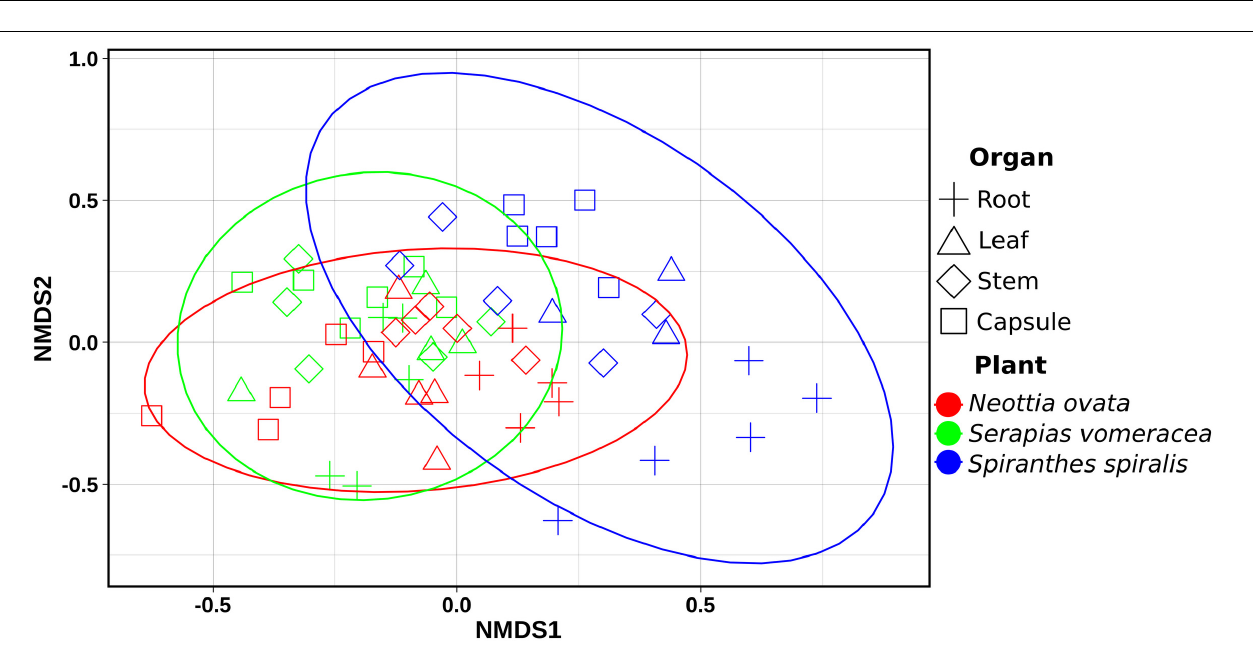
FIGURE 5 | Non-metric Multidimensional Scaling (NMDS) Plot visualization of beta diversity, using the Bray–Curtis distances, separating samples by orchid species/organs. Plot ellipses represent the 95% confidence regions for species clusters (stress = 0.24).